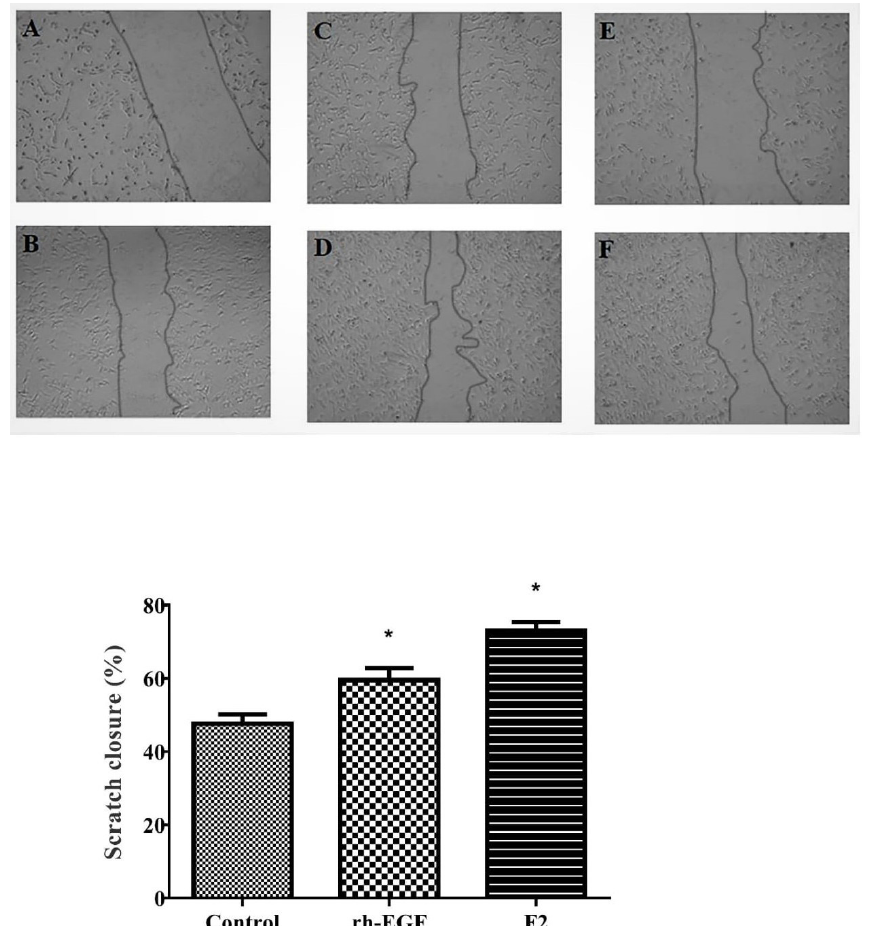
FIGURE 8 - Scratch test images of NIH 3T3 cell: A: Control group (t:0 h), B: Control group (t:24 h), C: rh- EGF (t:0 h), D: rh- EGF (t:24 h), E: F2 formulation (t:0 h), F: F2 formulation (t:24 h). F2 was the optimized formulation so was used in the scratch assay. Scratch closure ratio was measured using image analysis software. Values are the mean of triplicate determination (n = 3) ± standard deviation. Statistically significant value at * p < 0.05